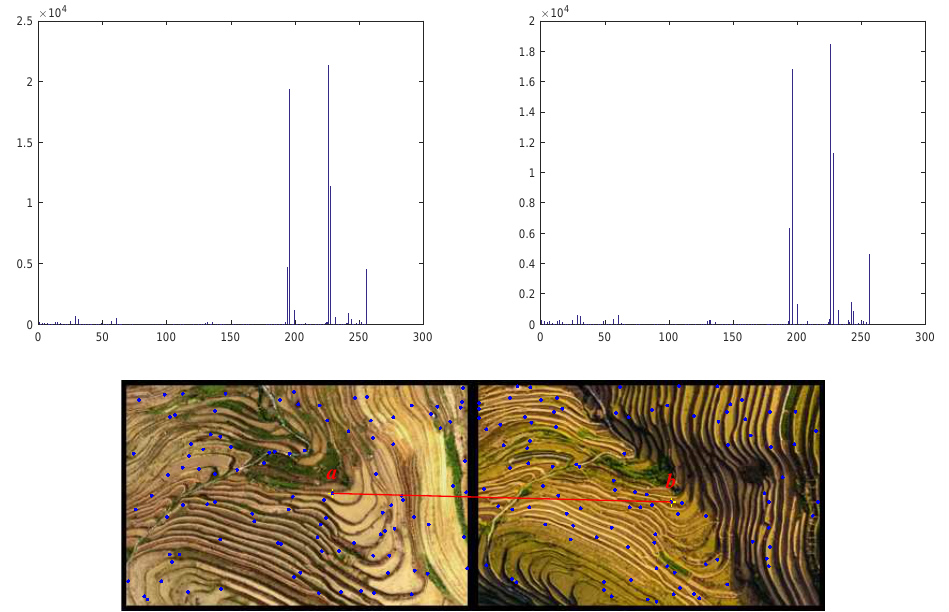
Figure 4. Example on estimating correspondence between two terrace images. In the first row, histograms of the points a and b are provided, respectively. In the second row, the points a and b are classified as the corresponding pair, which are connected by the red